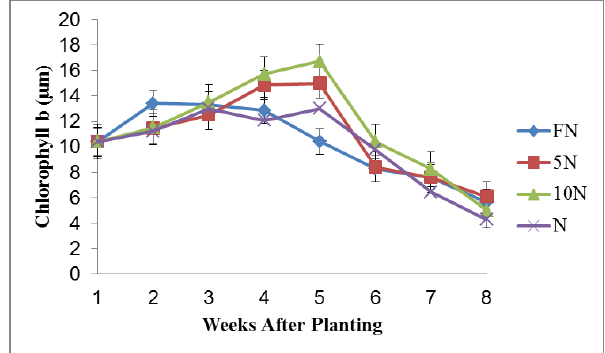
Fig. 1a. The effect of nitrogen nutritional stress on the chloro- phyll a accumulation of Vigna unguiculata measured at different periods